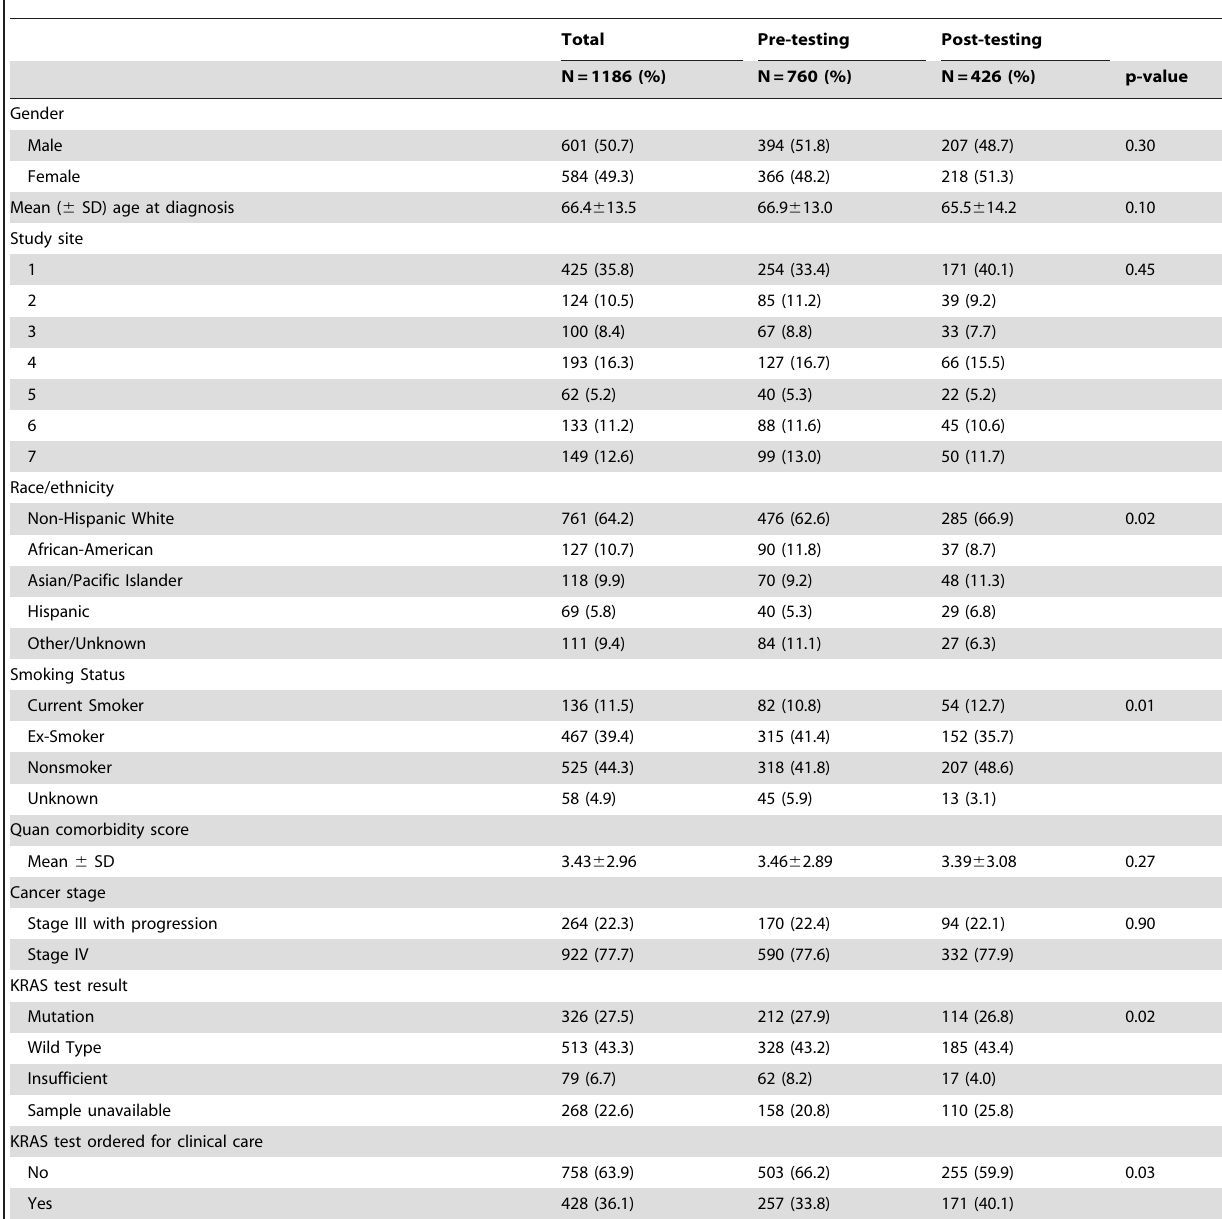
Table 1. Characteristics of 1,186 patients diagnosed with metastatic colorectal cancer by group (diagnosis before or after July 1,